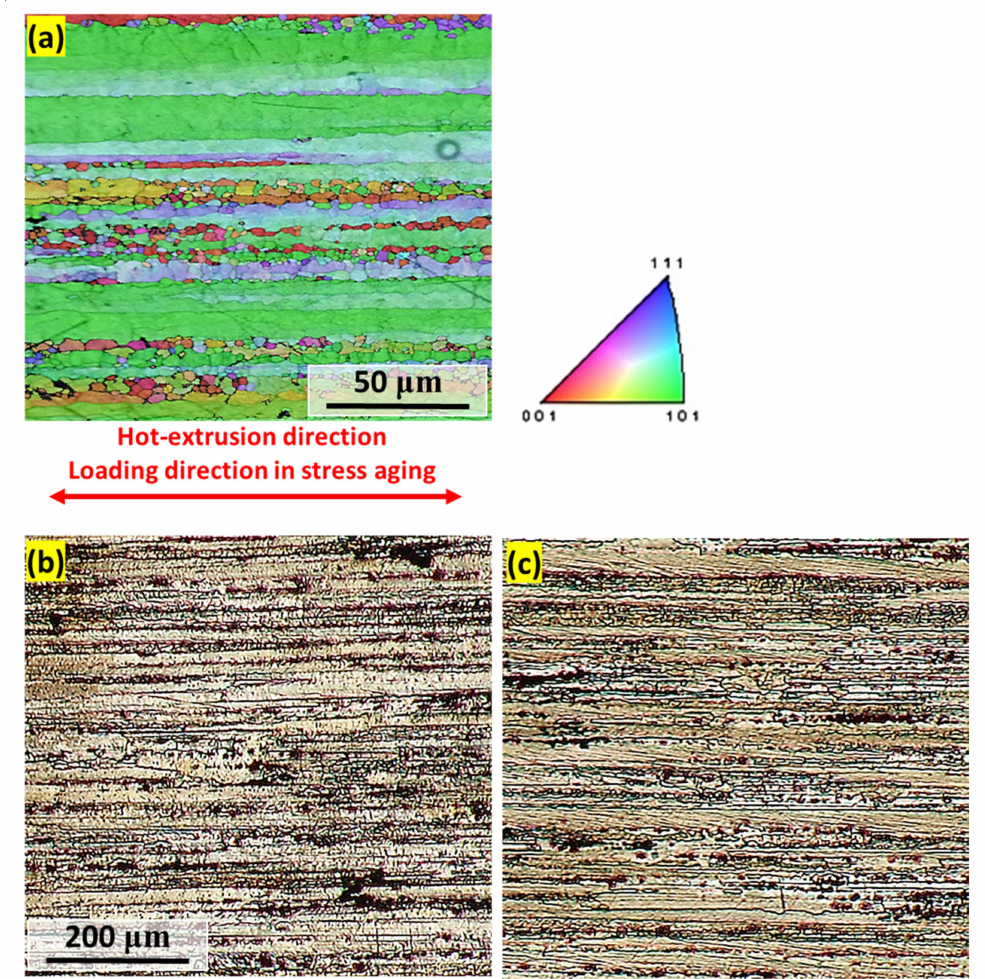
Figure 6. ( a ) EBSD inverse pole figure (IPF) map with superimposed image quality (IQ) of the as-received (T6) condition; optical micrograph of the samples aged at 120 ◦ C ( b ) with 0 MPa for 2 h and ( c ) 50 MPa for 24 h. The optical micrographs were captured at the same magnification (see text for